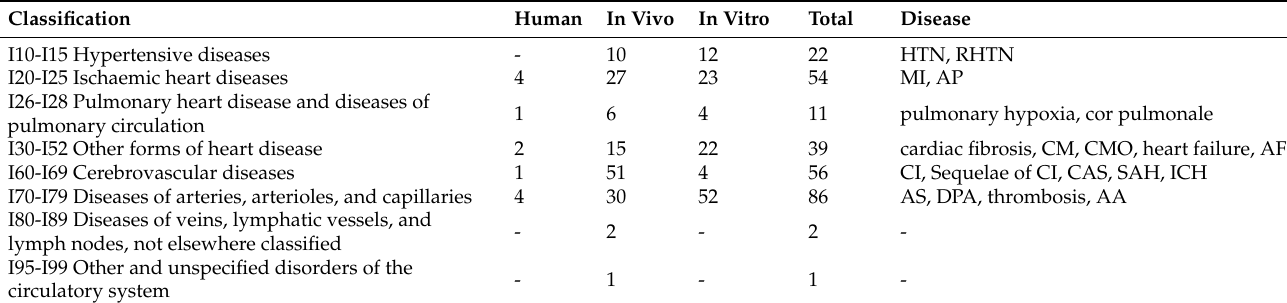
Table 3. The statistics of pharmacological results and its major diseases of SMC by experimental type in Chapter IX Diseases of the circulatory system of